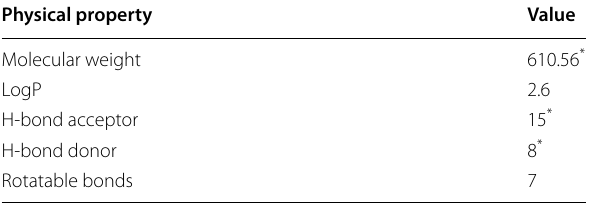
Table 2 Lipinski rule of five from SwissAdme server